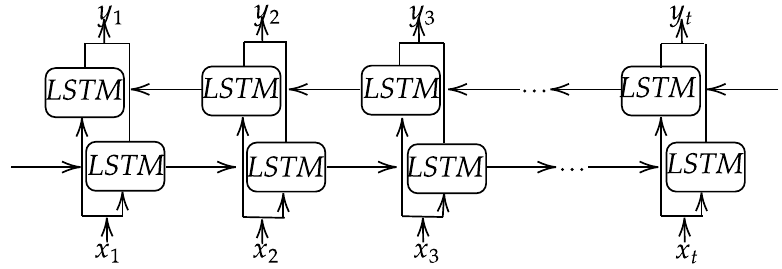
Figure 1. Bidirectional LSTM layer. Reprinted from ref